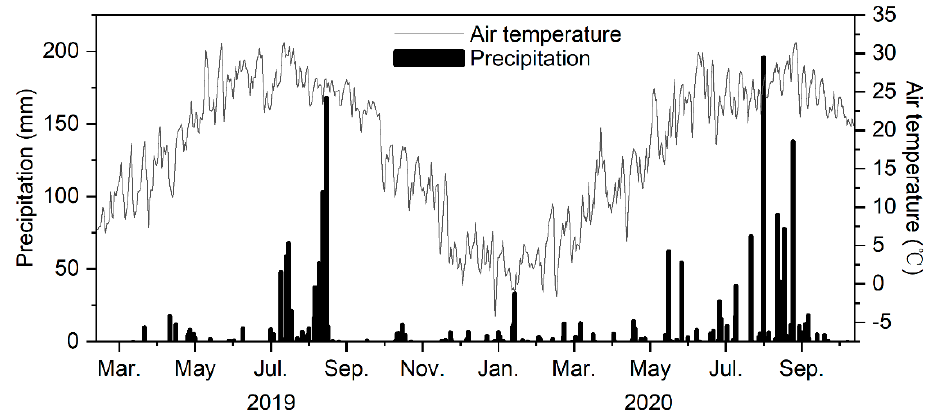
Figure 1. Average daily temperature and precipitation in 2019–2020.